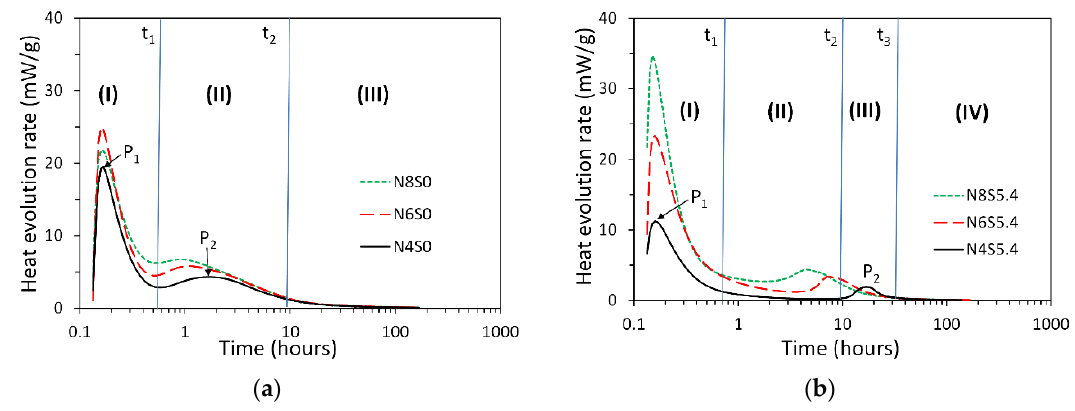
Figure 3. Heat evolution rates for sodium hydroxide ( a ) and sodium silicate ( b ) activated slag pastes. In the graph, t 1 , t 2 and t 3 stand for the transition time.